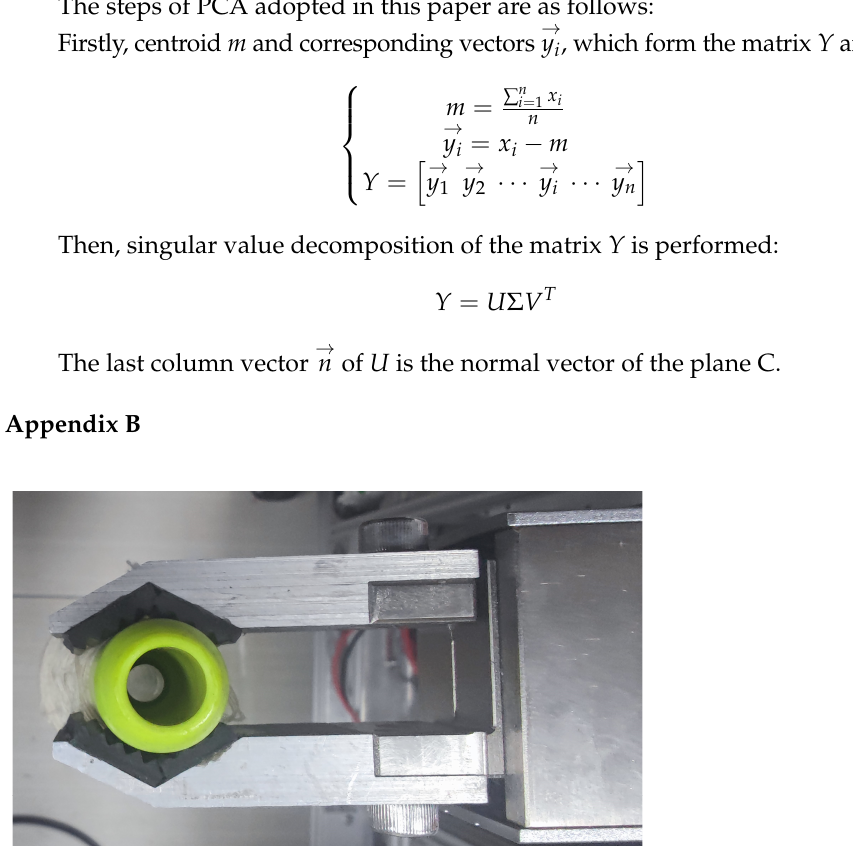
Figure A1. Way to grasp the bobbin.